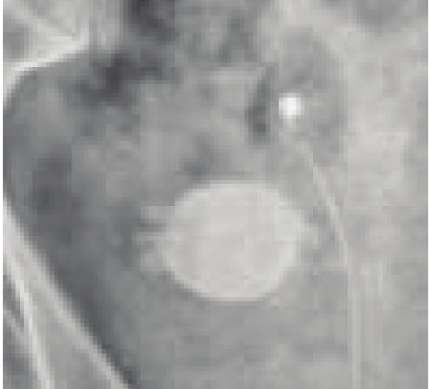
Figure 2: Magnified film showing spiculated bladder